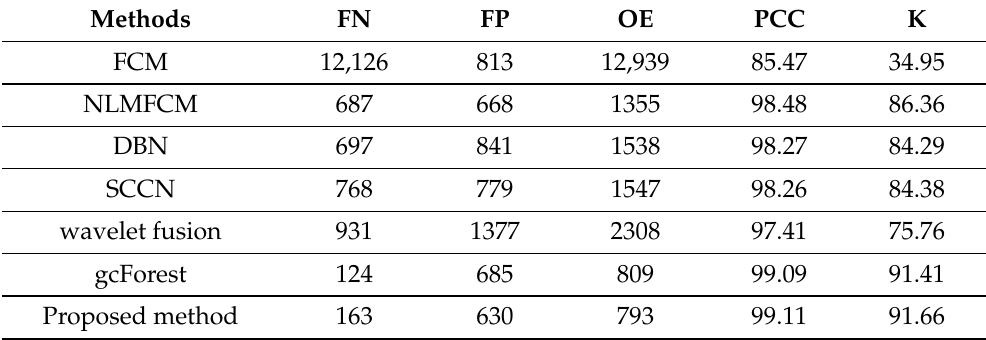
Table 14. Quantitative results for SAR images [117].